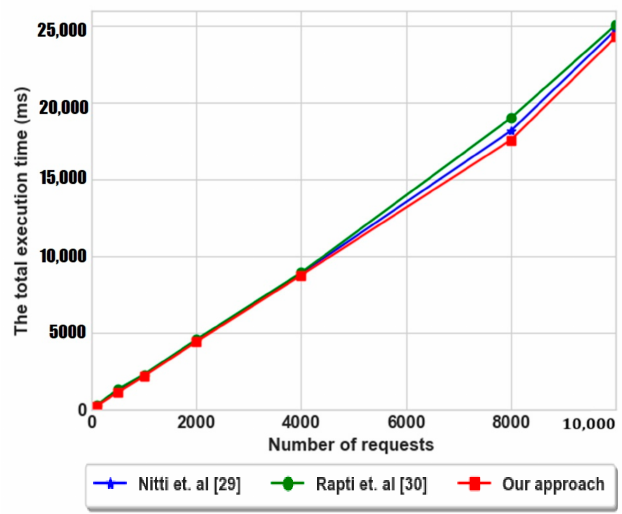
Figure 12. The total execution time during service search.